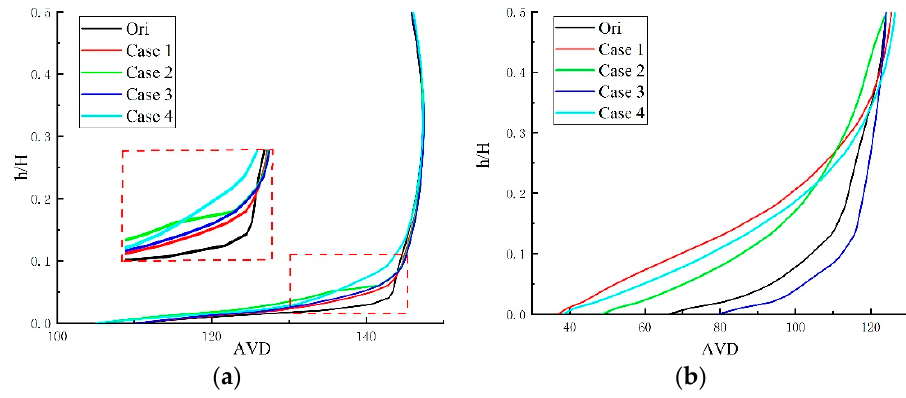
Figure 14. Radial distribution of AVD for ( a ) OP1 and ( b ) OP2.